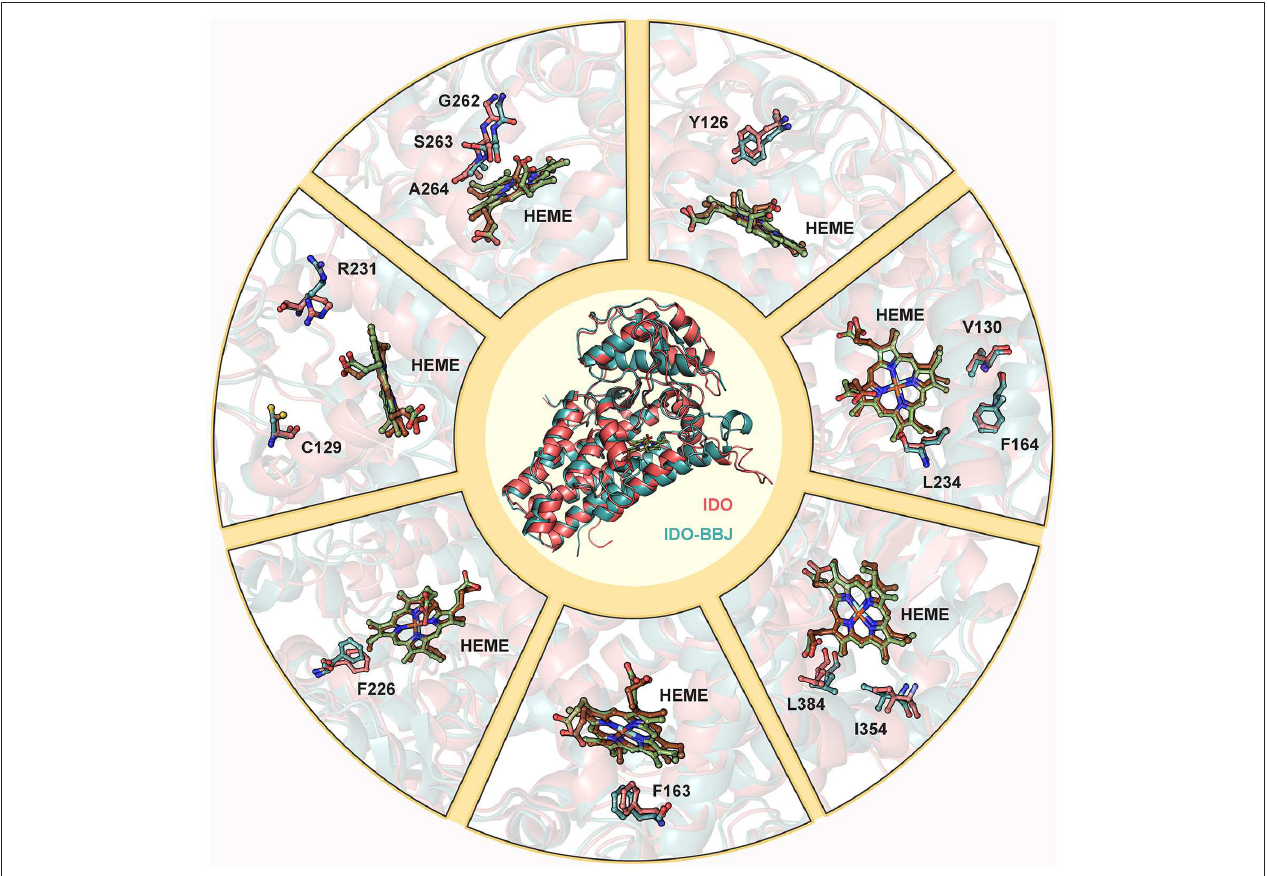
FIGURE 7 | Superimposition of key residues in IDO and IDO-BBJ systems. Hemes in IDO and IDO-BBJ are shown in green and brown,